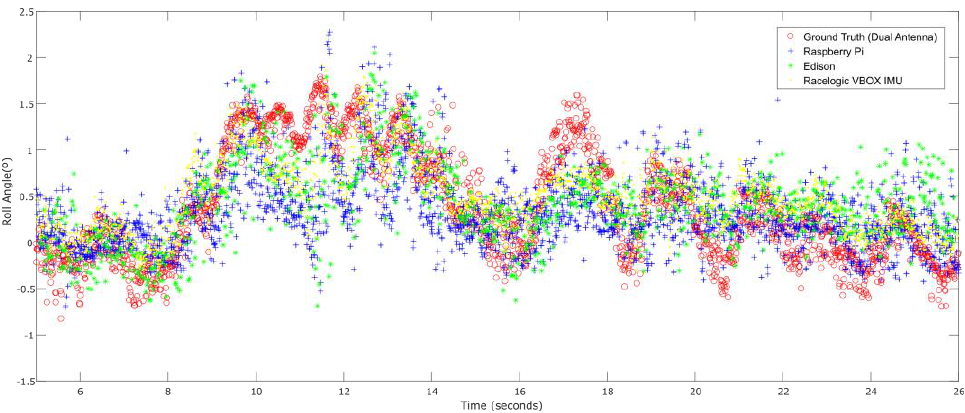
Figure 10. ANN estimated + ground truth roll angle for double lane change. Table 5. Test 2. Errors of estimated roll angle on Raspberry Pi 3 Model B and Intel Edison compared with the measured roll from VBOX (ground truth).